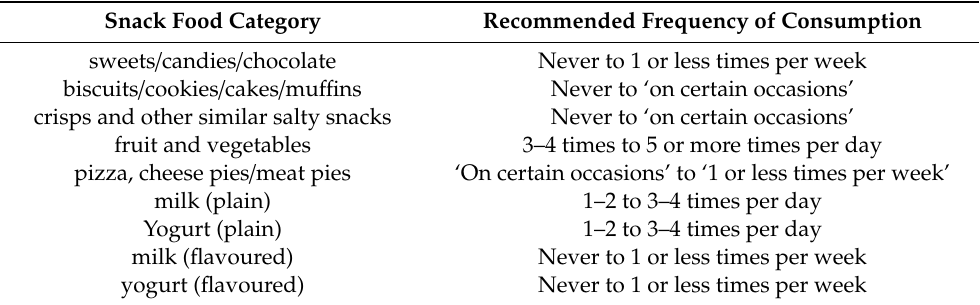
Table 2. Description of recommendations for frequency consumption of di ff erent snack food categories for preschool